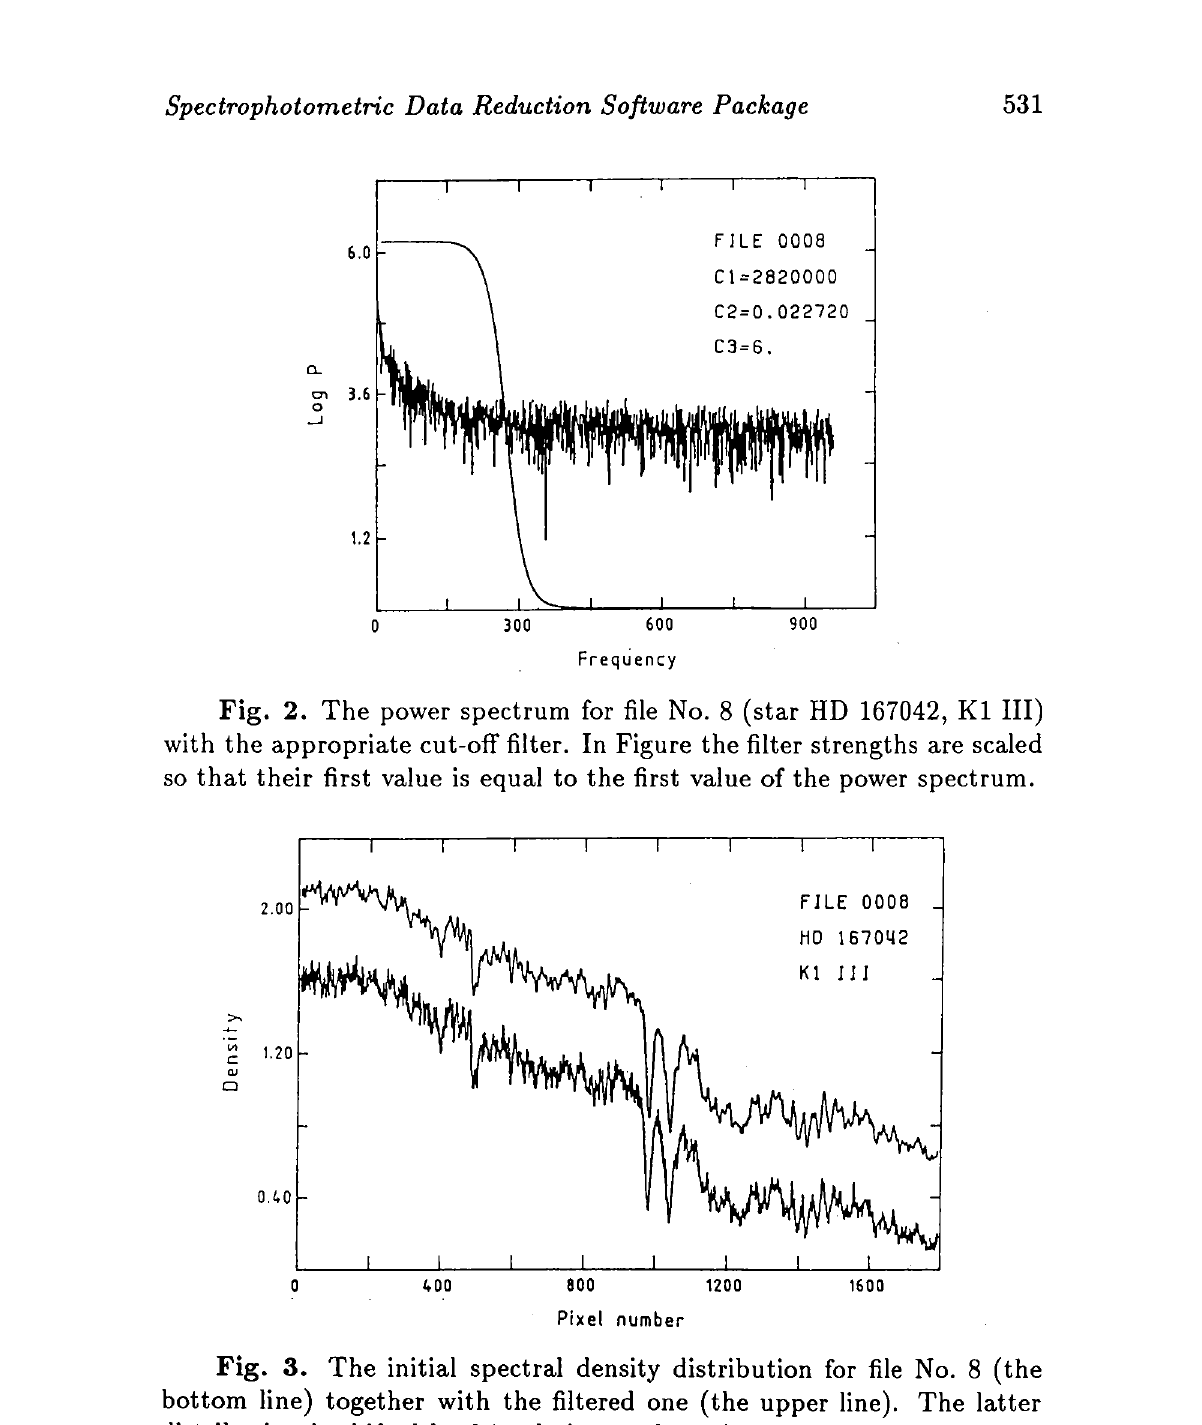
Fig. 3. The initial spectral density distribution for file No. 8 (the bottom line) together with the filtered one (the upper line). The latter distribution is shifted by 0.5 relative to the ordinate